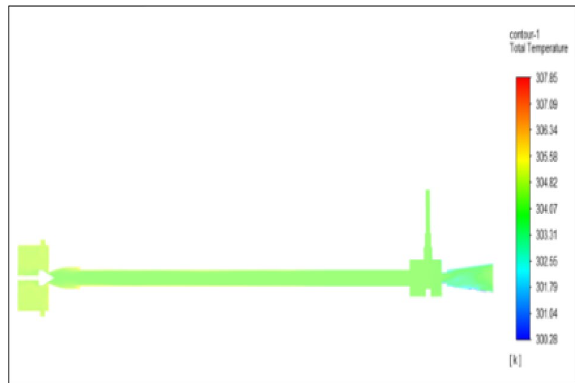
Figure 26. Copper at 6 bar.